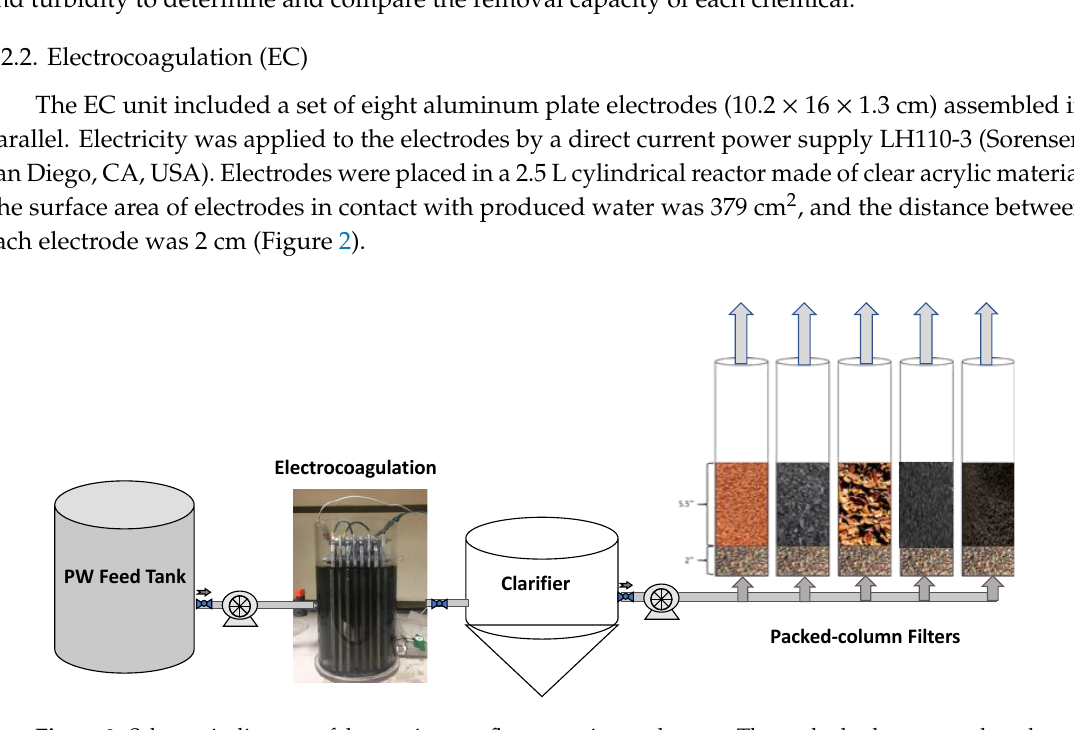
Figure 2. Schematic diagram of the continuous-flow experimental set up. The packed columns employed different media, from left to right: walnut shell, biochar, pecan shell, new GAC, and spent GAC.